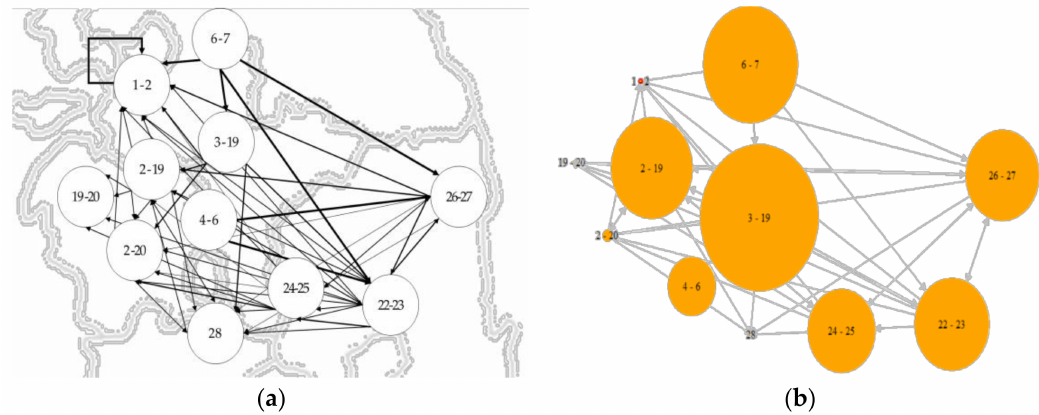
Figure 5. Visualization of a cascading sequence simulation: ( a ) Cascading sequence path; ( b ) Cascading probability visualization.